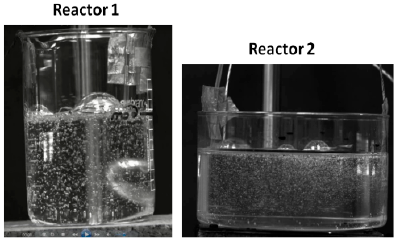
Figure 4. Pictures of the 3 used air lift reactors (diameter × height mm): n°1 (85 × 105 mm) and n°2. (140 × 105 mm).